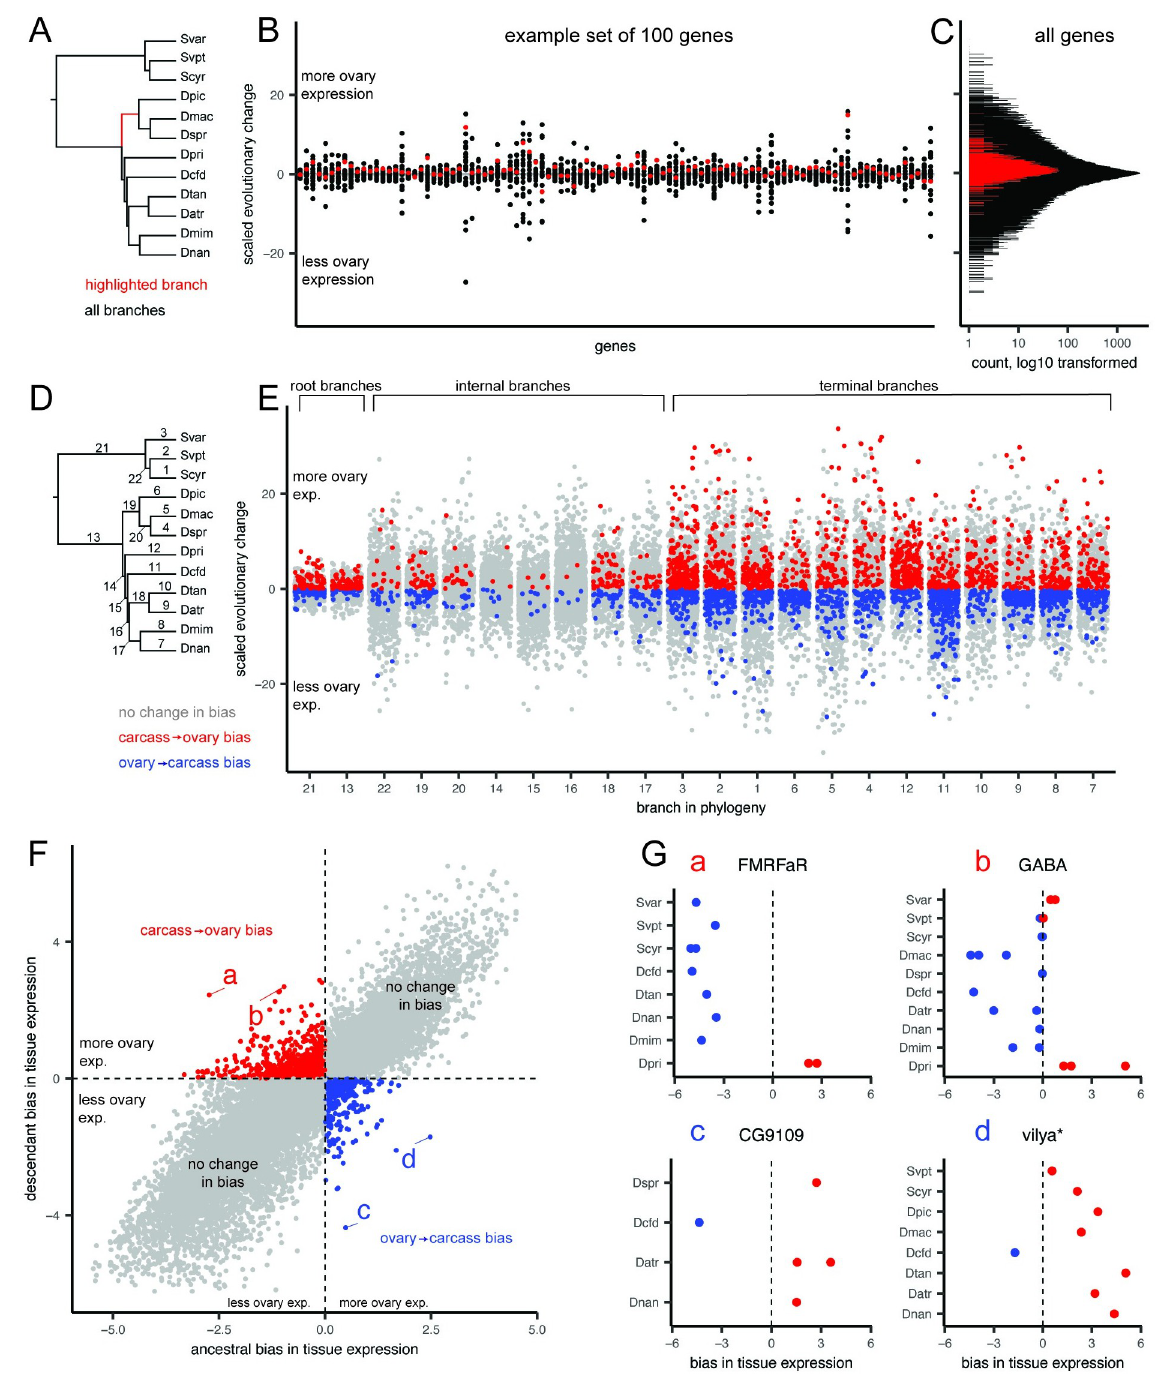
Fig 4. Identifying genes that have gained and lost ovary-biased expression across the phylogeny. A, The phylogeny of the twelve species studied here, highlighting one example branch of the 22 for which we inferred the scaled evolutionary change in expression bias. B, The distribution of changes, grouped by gene, for 100 randomly selected genes, defined by homology group. Each point represents one of the 22 branches from A, with the red point corresponding to the highlighted branch from that panel. C, The distribution, log 10 transformed, of scaled genes across all branches and all genes. Changes on the highlighted branch in red. D, The phylogeny with all 22 branches numbered. E, The distribution of changes, grouped by branch, with random jitter on the x-axis within each group. Points colored according to the qualitative change in bias, either from more expression in ovary than carcass to less (blue), the reverse (red), or no change in overall bias (gray). F, The distribution of ancestral and descendant values, showing the two quadrants that represent qualitative changes in bias. Points that represent